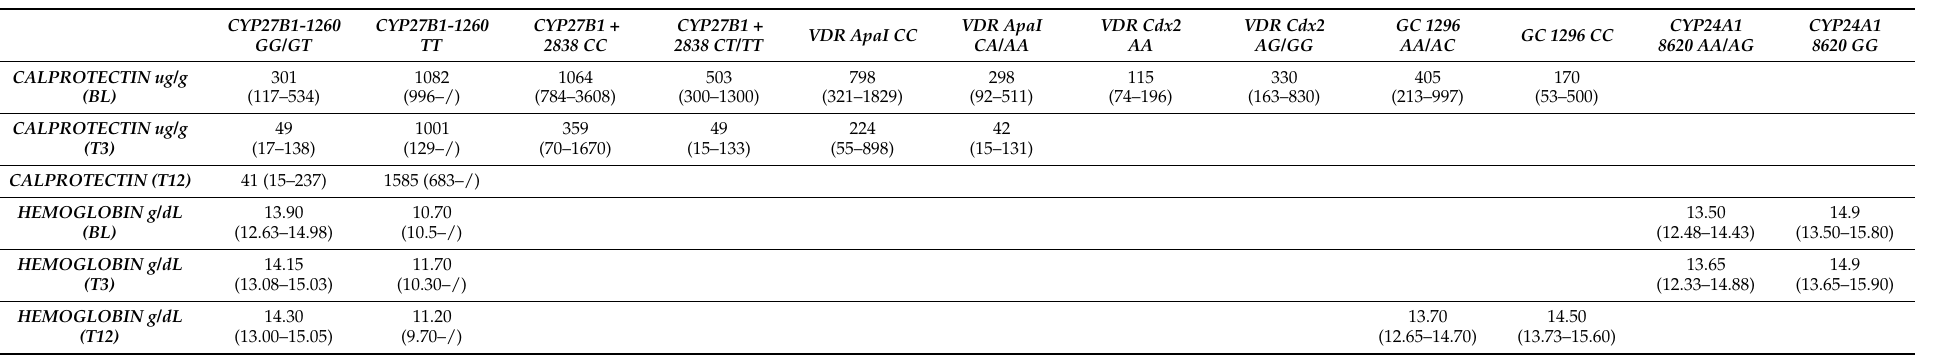
Table 2. Median levels of calprotectin and hemoglobin according to vitamin D-related gene polymorphisms at the three different time